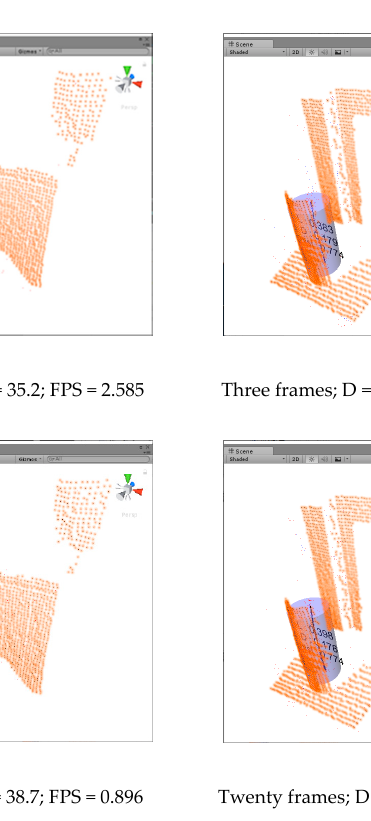
Figure 15. Multi frames center axis estimation (cm).